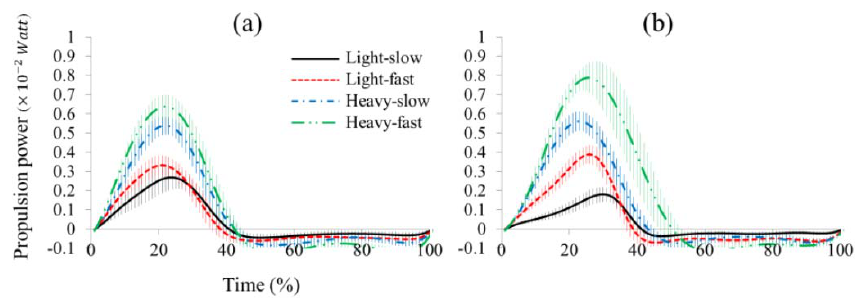
Figure 5. Mean propulsion powers for (a) unskilled and (b) skilled groups during manual wheelchair propulsion under four different conditions